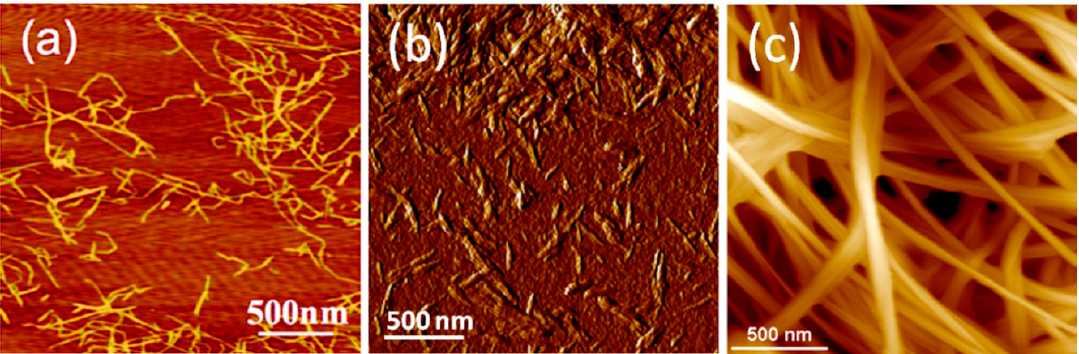
Figure 1. AFM images of ( a ) cellulose nanofibrils (CNF) [23], ( b ) cellulose nanocrystals (CNC) [24] and ( c ) bacterial cellulose (BC) [6].